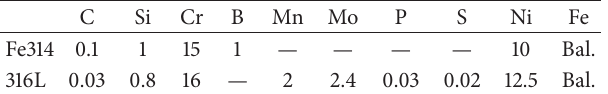
Table3:Chemicalcompositionofthealloypowderusedingreycast iron repair (wt.%).